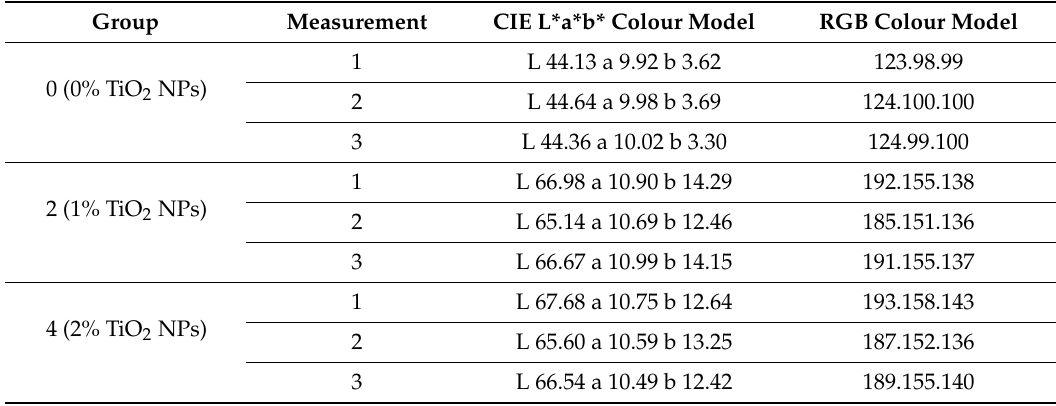
Table 7. Nanocomposite colour